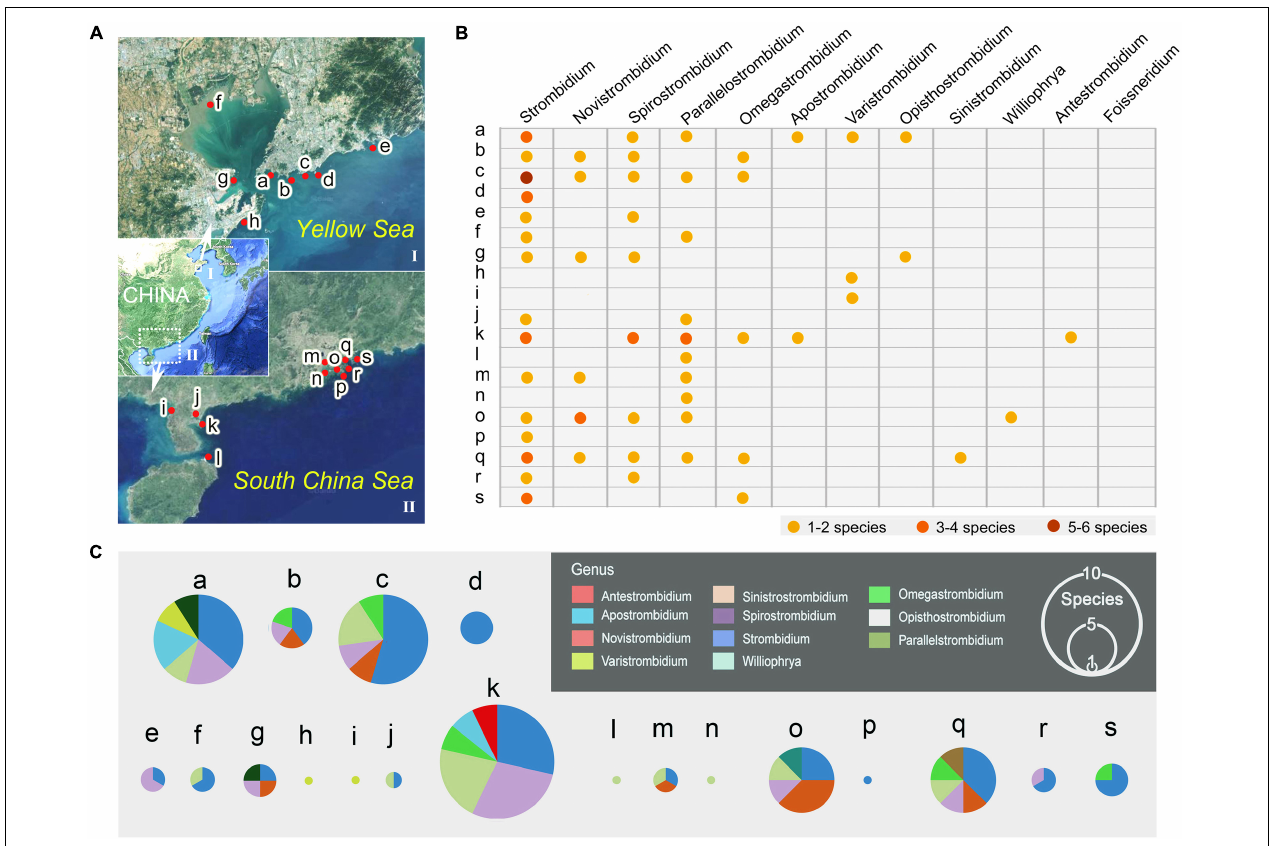
FIGURE 1 | Geographic distribution of the 12 genera of the family Strombidiidae in China. (A) Showing sampling sites in northern (I) Chinese coastal waters near Qingdao, Shandong Province, and in southern (II) Chinese coastal waters in Guangdong Province and Hainan Province. Red spots on the map mark the locations where species were collected. Location a: Intertidal zone in Qingdao. b: Intertidal zone in Qingdao. c: Coastal waters in Qingdao. d: Beach and reef in Qingdao. e: Beach and reef in Qingdao. f: Intertidal zone in Jiaozhou Bay. g. Intertidal zone in Huangdao. h. Beach in Huangdao. i: Intertidal zone in Zhanjiang. j: Coastal waters in Zhanjiang. k: Mangrove wetland in Zhanjiang. l. Estuary in Haikou. m. Estuary in Guangzhou. n. Coastal waters in Zhuhai. o. Mangrove wetland in Shenzhen. p. Dock in Shenzhen. q. Intertidal zone in Huizhou. r. Mariculture zone in Huizhou. s. Mangrove wetland in Daya Bay. (B) The table shows the occurrence and species diversity of each genus at each sampling site. (C) The pie charts show the species composition of each sampling site, the size of the pie indicates the species richness in each